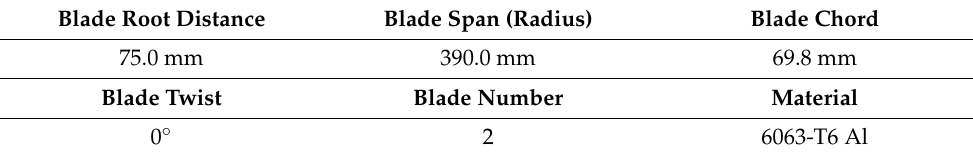
Table 1. P-RSB Geometric Characteristics.